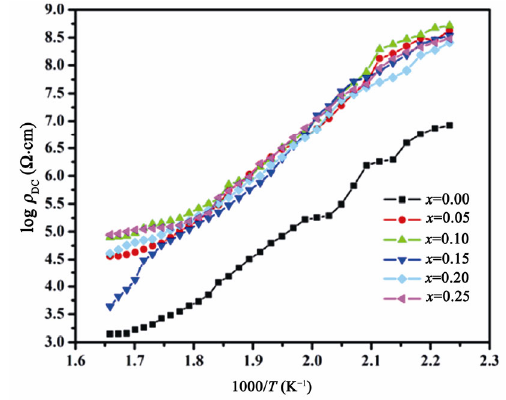
Fig. 5 DC resistivity ( perature (1000/ T ) for all the